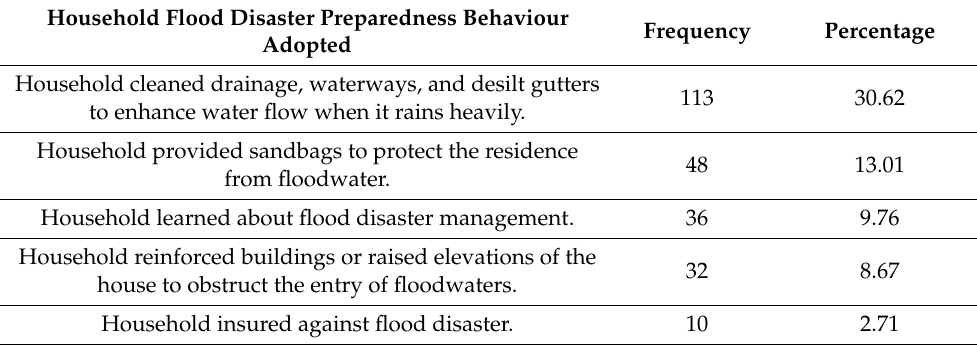
Table 1. Frequency distribution of urban households’ flood disaster preparedness behaviour in the Odaw river flood plains study area ( n = 369).